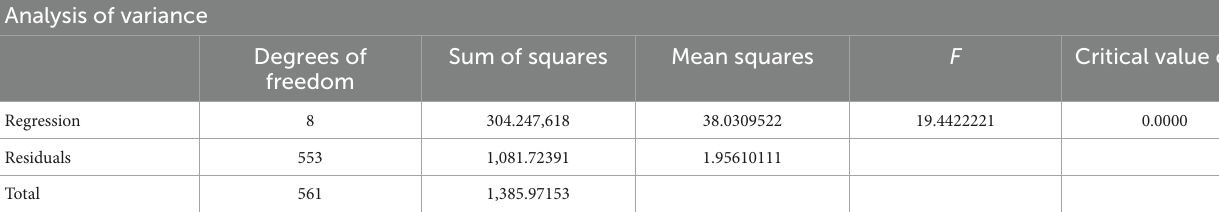
TABLE 7 Analysis of variance.